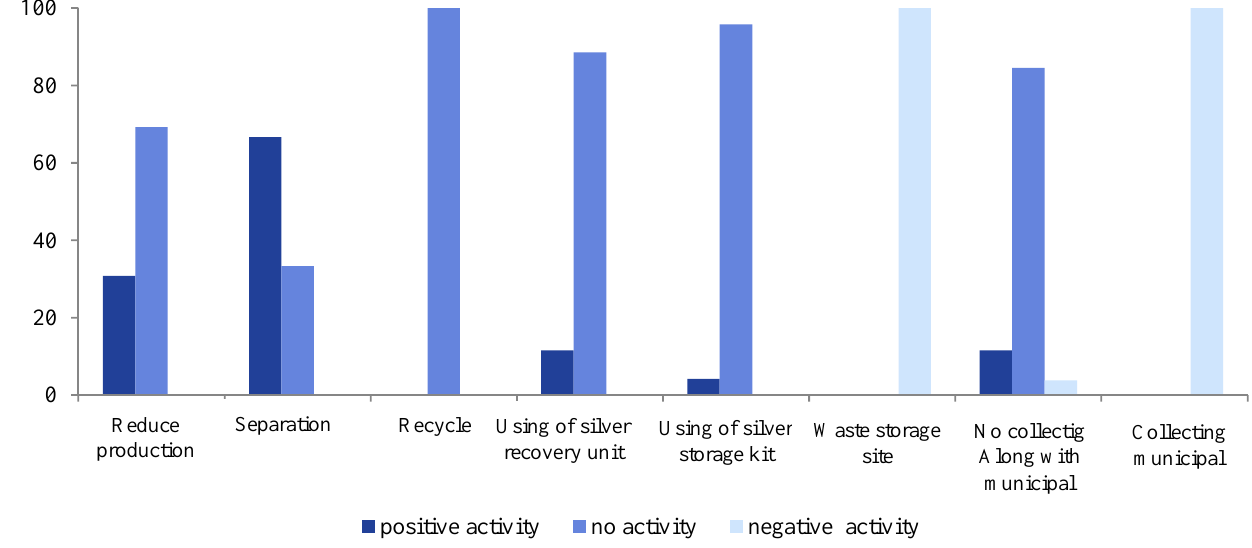
Figure 1. The percentage of the functional element of dental solid waste management in Sari Table 2. Method for dentistry offices waste management in Sari based on questionnaires Type of